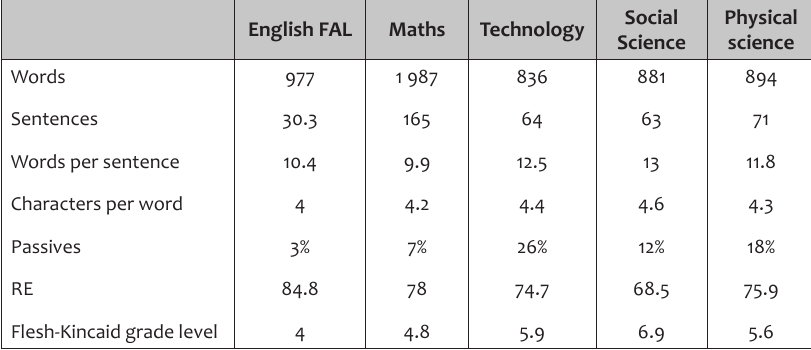
Table 3: Flesch RE in Grade 5 textbooks English FAL